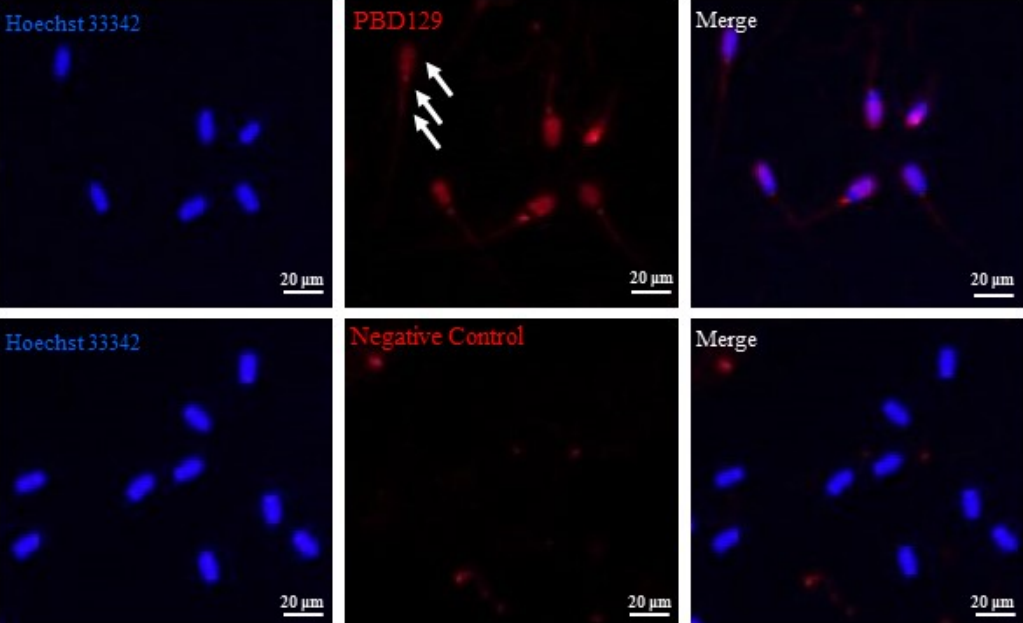
Figure 6. Indirect immunofluorescence analysis of the localization of pBD129 protein in sperm. White arrows indicate pBD129 protein abundance. Hoechst33342 indicates nuclear staining; red indicates pBD129 protein abundance; Merge is nuclear staining and pBD129 protein overlay.